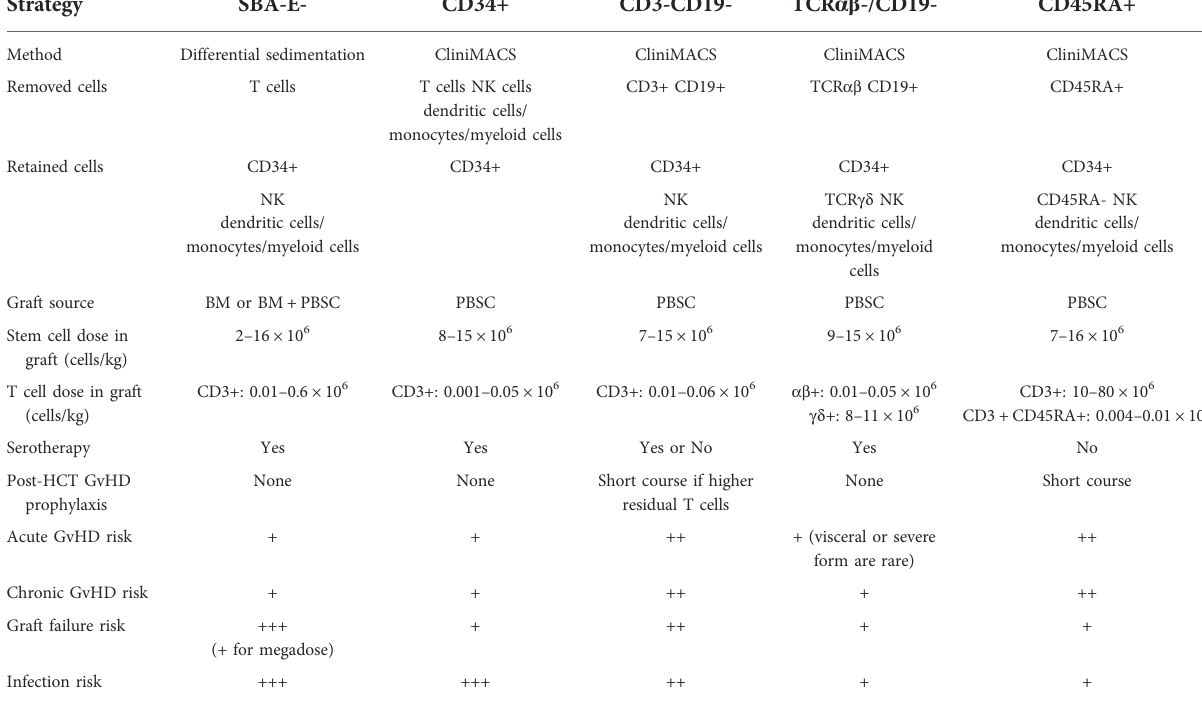
TABLE 1 Comparison of common ex vivo T-cell depletion